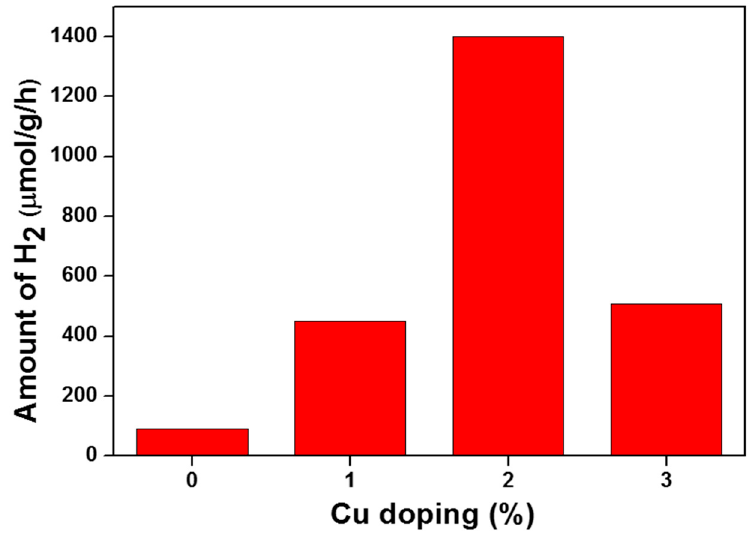
Figure 9. E ff ect of Cu doping on H 2 evolution under natural solar light. Figure 9. Effect of Cu doping on H 2 evolution under natural solar light.